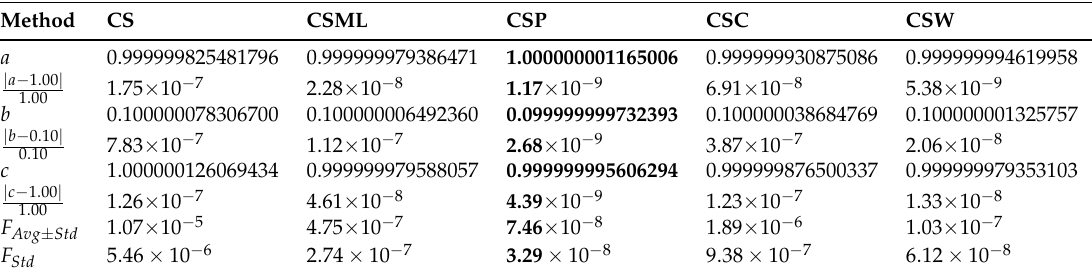
Table 5. Statistical results of different methods for system (16), in terms of the average estimated values, the relative error values and objective function